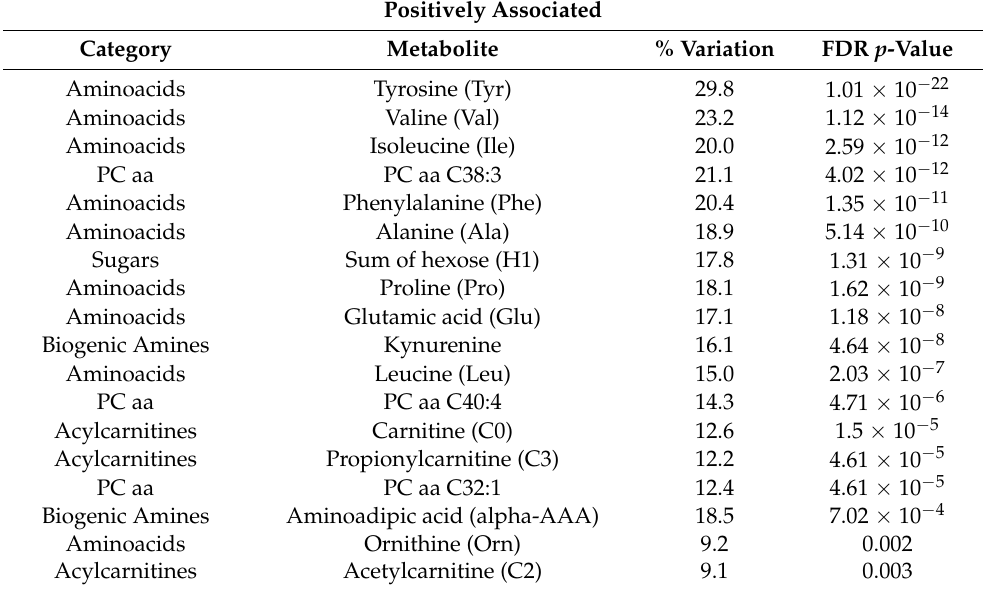
Table 2. Metabolites significantly associated with body mass index (BMI) in the censored linear regression Tobit models. The dependent variable was the log transformed and standardized concen- tration of a given metabolite, while independent variables were BMI, age, sex, and smoking habit. For each metabolite, the percent of variation was calculated with the formula: (exp( β ) − 1) × 100, where β was the slope representing the increase of the metabolite in relation to the increase of BMI. The p -values adjusted for multiple testing by controlling the false discovery rate (FDR) are also reported. Only metabolites with FDR p -values lower than 0.05 were included in this table; complete results are reported in Supplementary Materials (Table